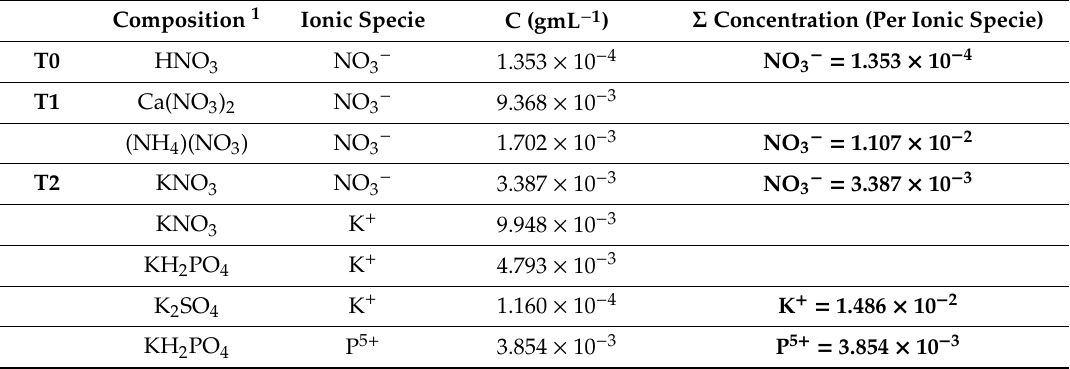
Table 4. Laboratorial reproduction of irrigation tanks composition and cumulative target species